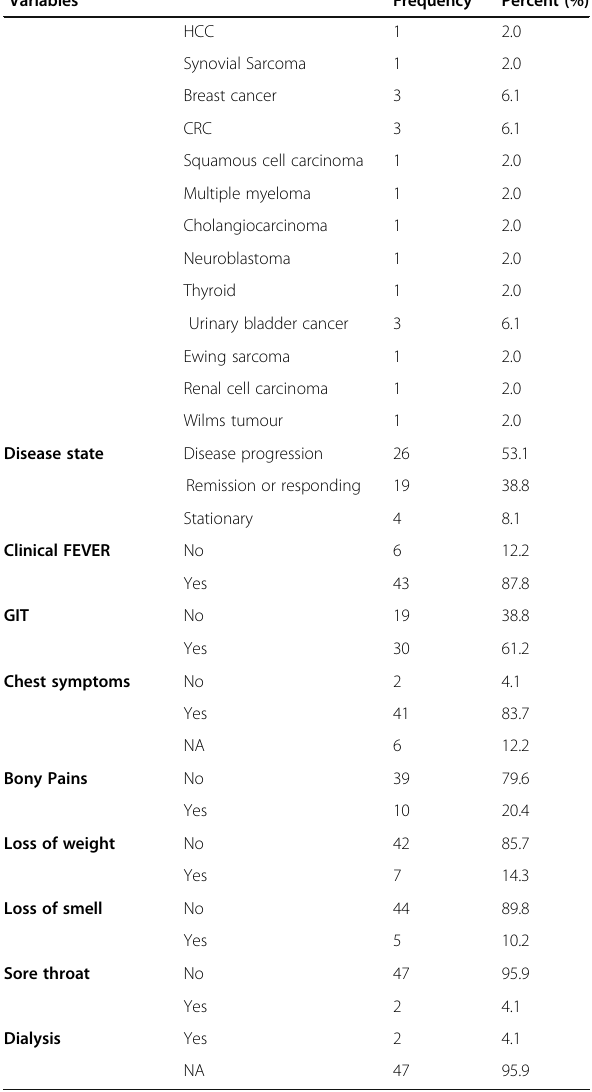
Table 1 Clinical features of the assessed COVID-19 infected cancer patients (Continued)